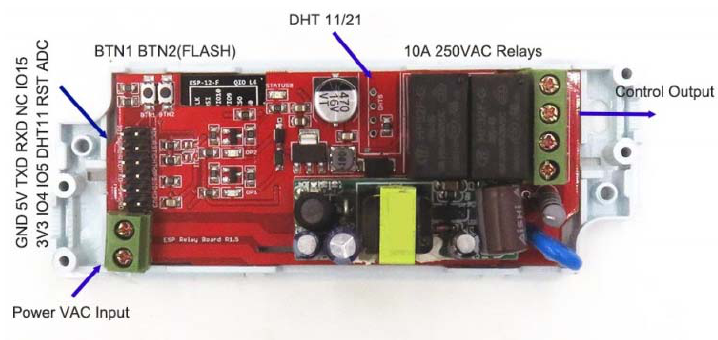
Figure 4. Electronic board Electrodragon ESP Relay.